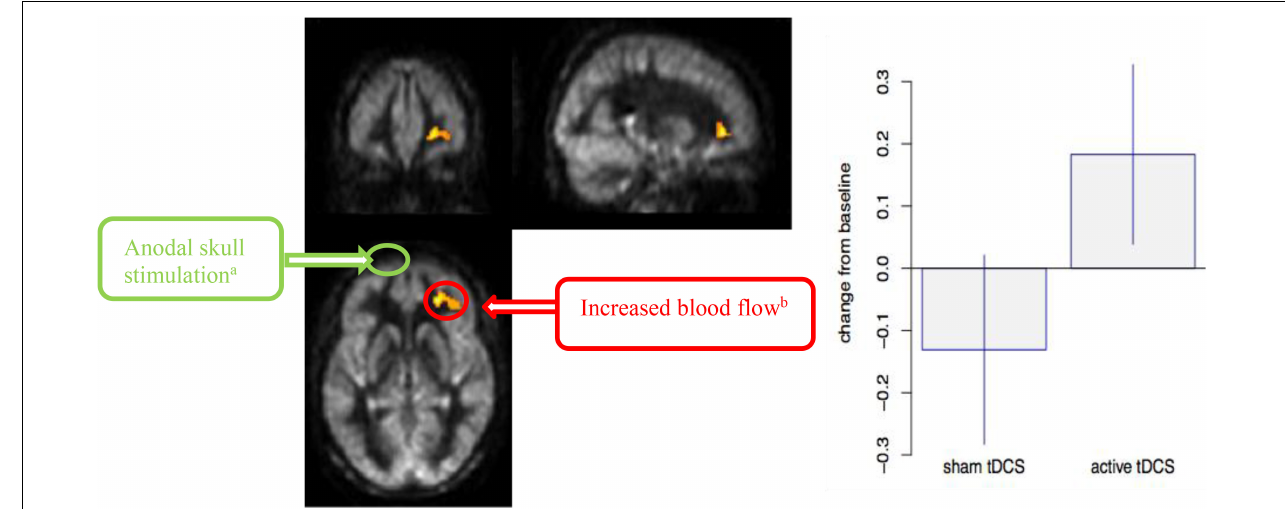
FIGURE 3 | Cerebral blood flow (CBF) voxel-based analysis for the interaction contrast, superimposed on average CBF map of all participants. Right Middle Frontal Cortex (MFC) was significant at a cluster p -value = 0.05 ( k = 1,168 mm 3 ). Representation of the anodal stimulation site (green circle) and increased CBF. We illustrate the contralateral nature of the anodal stimulation from the CBF changes. (A) Anodal skull stimulation over left inferior frontal gyrus (IFG) for a total 8 sessions for 20 min prior to cognitive training over 4-week period. (B) Increased blood flow in right MFC after completing cognitive training